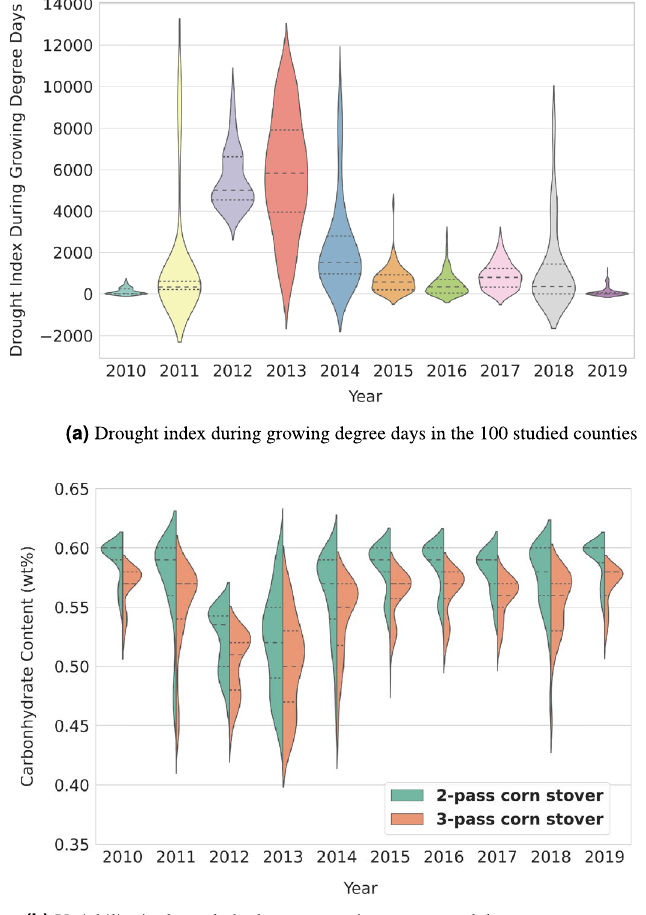
Figure 1. Variability in drought index and carbohydrate contents during